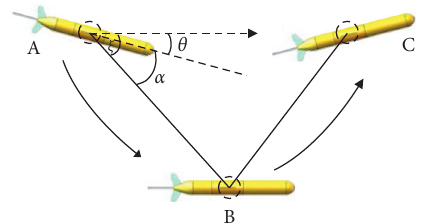
Figure 3: Single glide cycle abridged general